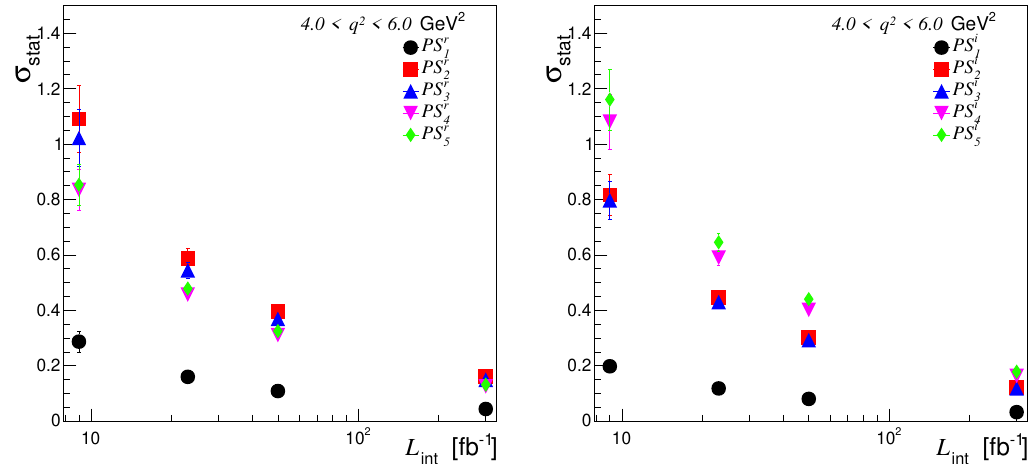
Figure 11 . Estimated statistical uncertainty for the (left) real and (right) imaginary optimised in- terference observables PS i as a function of integrated luminosity for the q 2 bin 4 . 0 < q 2 < 6 . 0 GeV 2 .